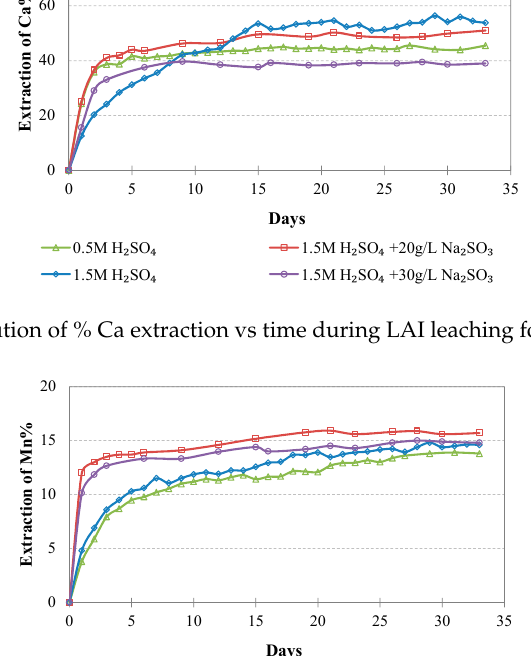
Figure 9. Evolution of % Al extraction vs time during LAI leaching for different tests.